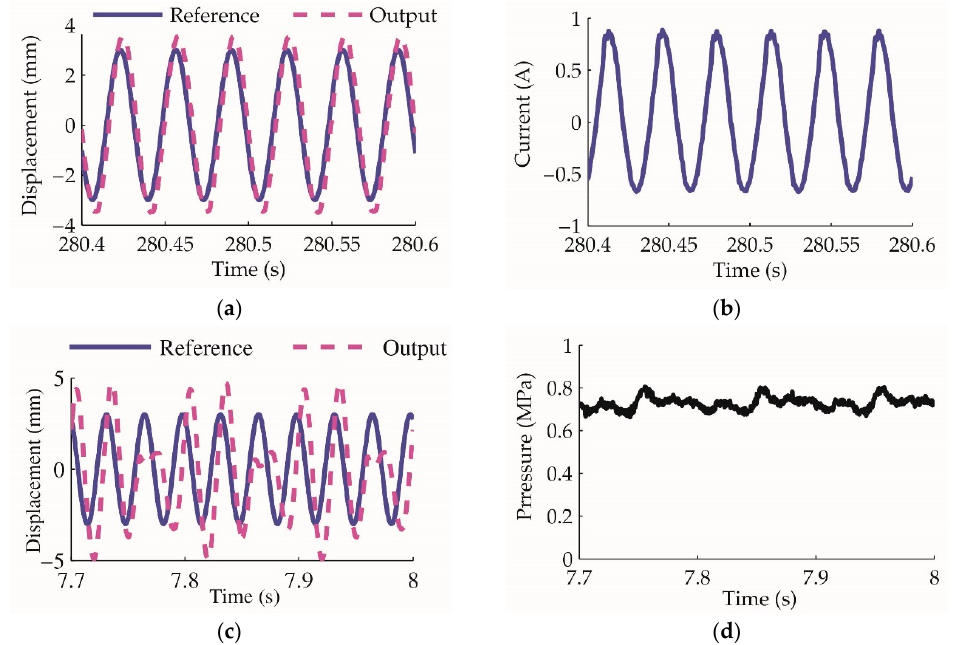
Figure 13. Linear motor oscillation closed-loop control experiment: ( a ) displacement reference and output without load; ( b ) current of the motor winding without load; ( c ) displacement reference and output with load; ( d ) the pressure acted on the motor mover is approximately 0.7 MPa, and for the effective area of the mover piston it is 48.1 mm 2 according to Table 2, the equivalent force is 34 N.